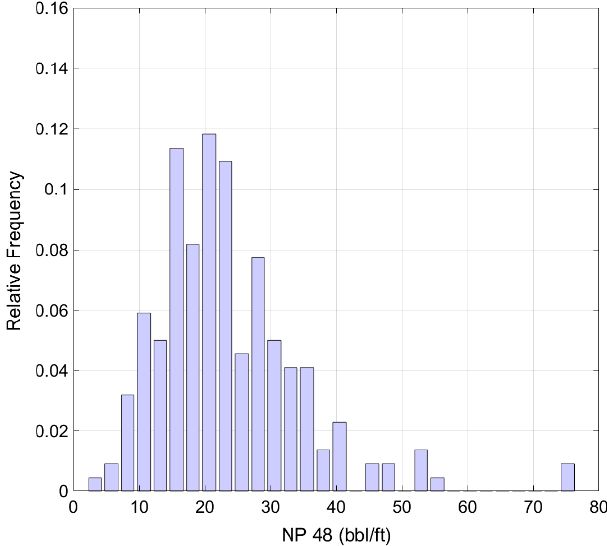
Figure 14. Estimated production results of all wells using the Arps hyperbolic for 12 months.